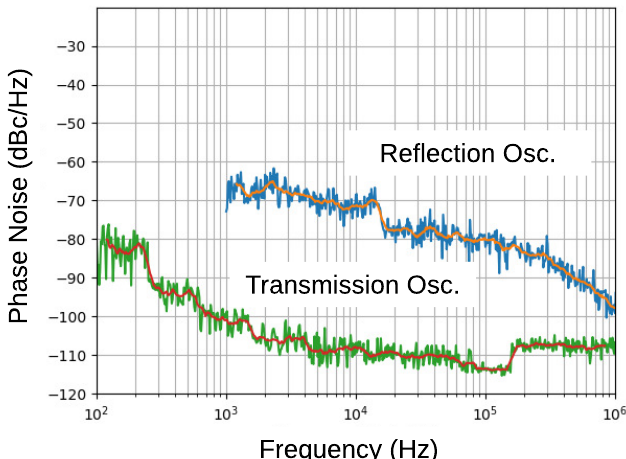
Figure 13. The phase noise of the fabricated transmission oscillator with that of the reflection oscillator. Moving averages are also plotted in the